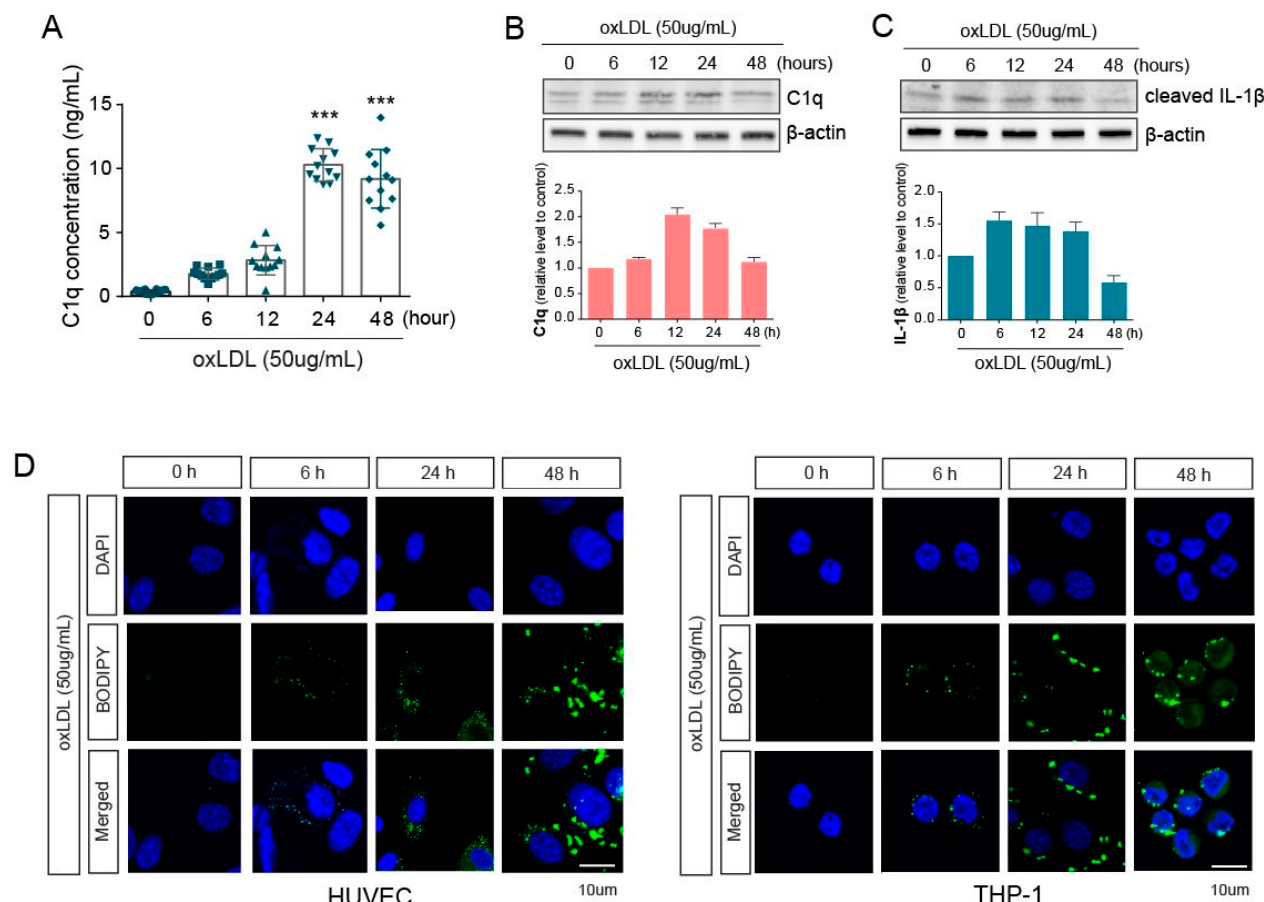
Figure 1. Exposure of oxLDL on co-cultured macrophages and endothelial cells. ( A ) C1q concentration in the supernatant collected from co-culture media was measured using ELISA. ( B ) The protein levels of C1q in HUVECs were assessed by western blotting in whole-cell lysates at several time points after oxLDL exposure. ( C ) The protein levels of cleaved IL-1 β were analyzed by western blotting in THP-1 whole-cell lysates at several time points after oxLDL exposure. ( D ) The accumulated lipids in HUVEC (left) and THP-1 (right) cells were stained with BODIPY and were detected by fluorescence microscopy. ***, p < 0.0001.